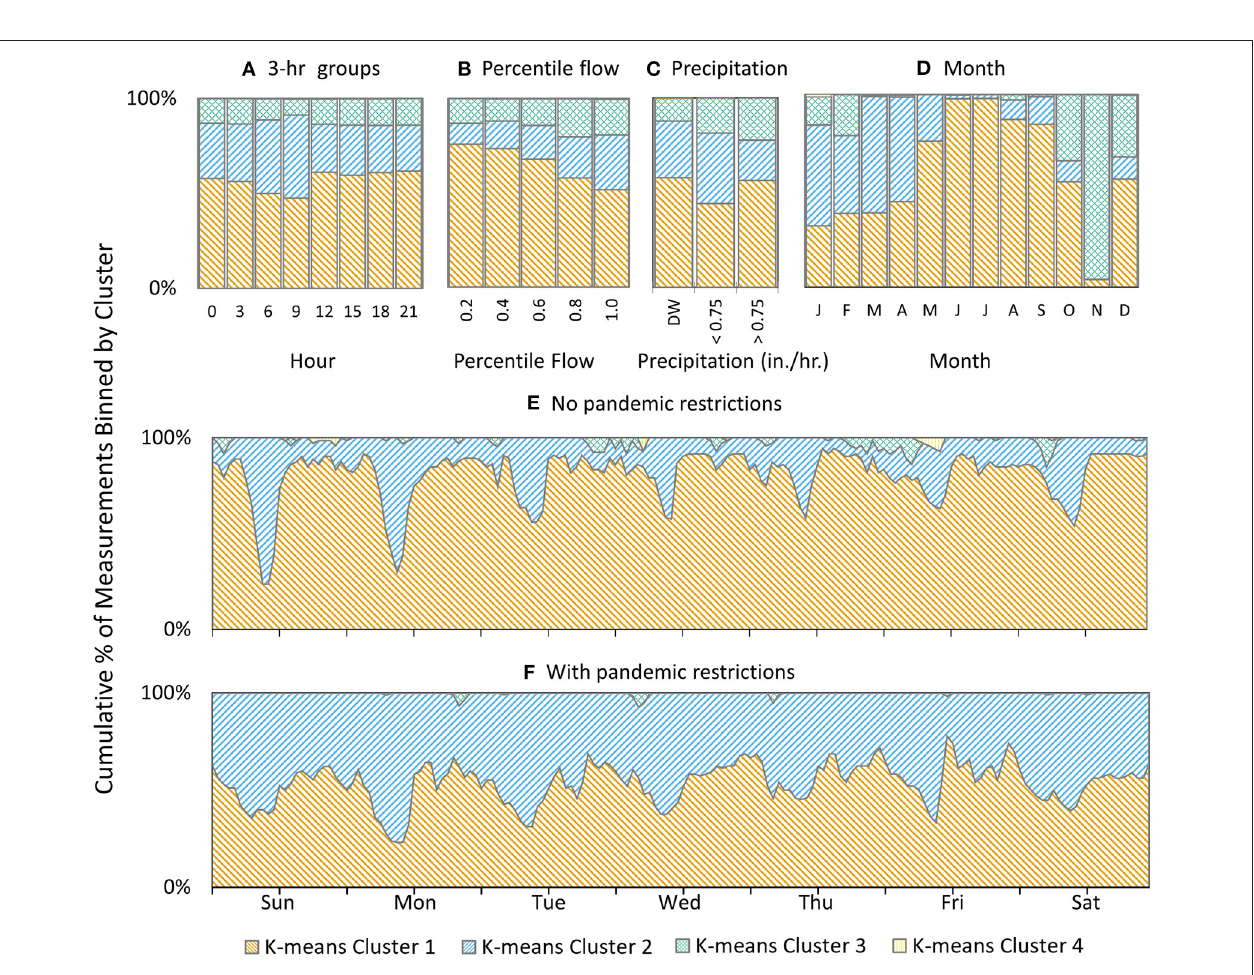
Frontiers in Water |